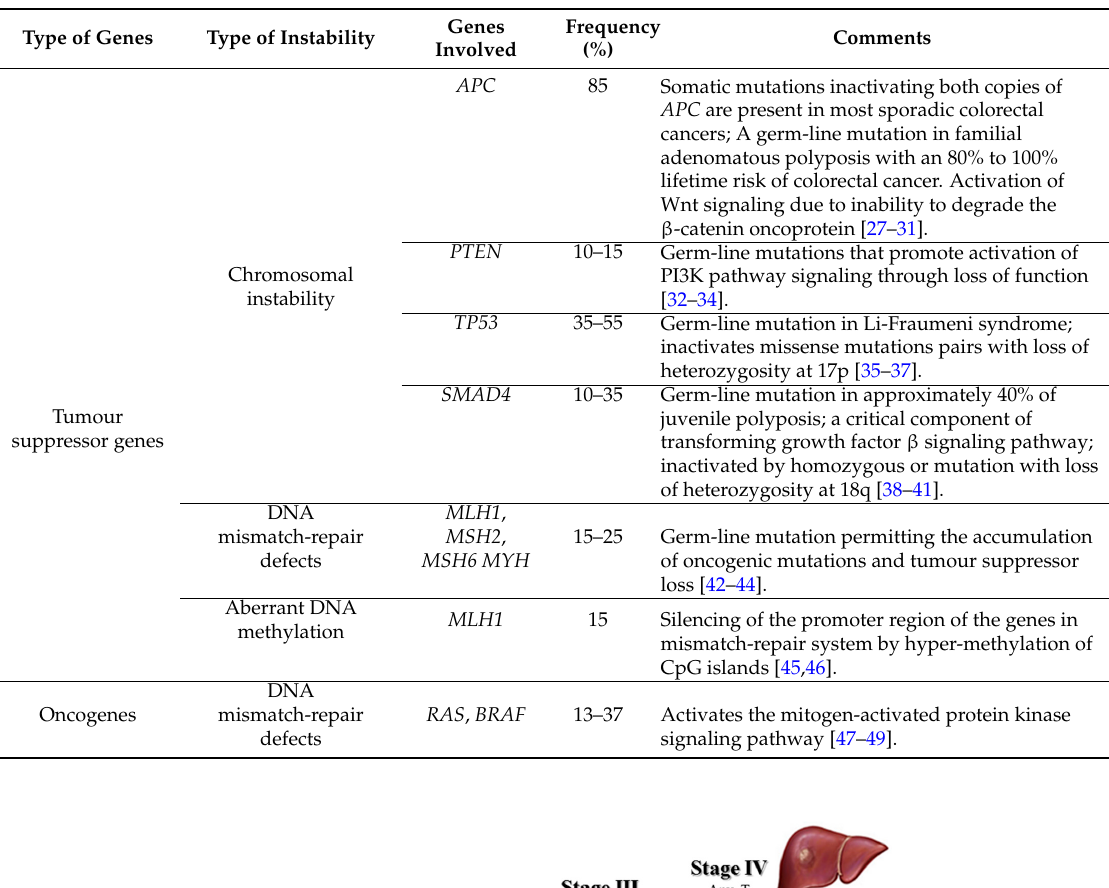
Table 1. Genomic Instability in Colorectal Cancer.